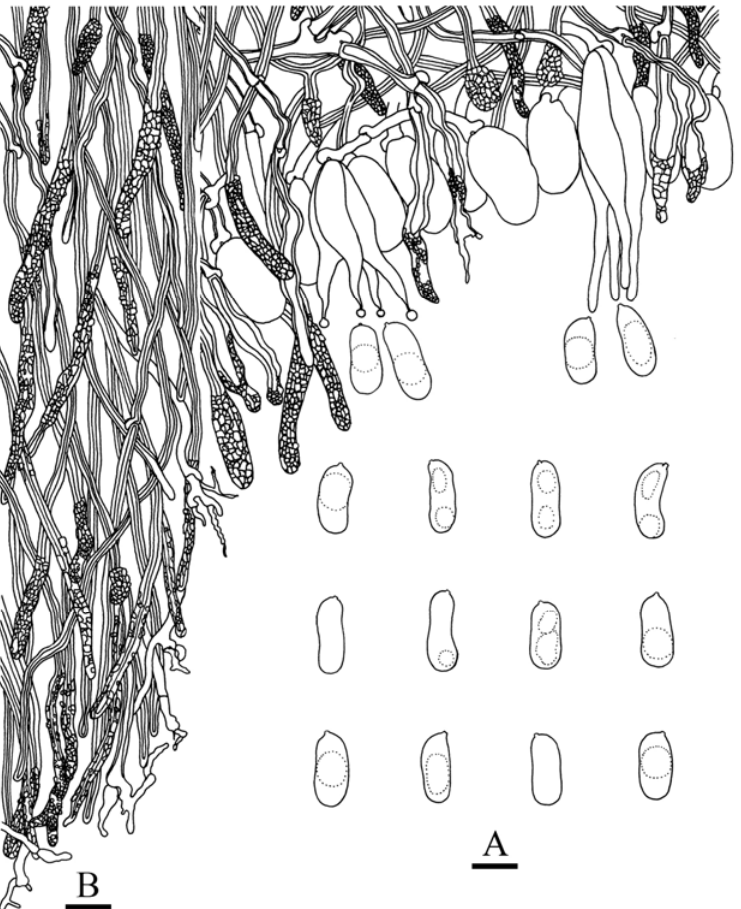
Figure 13. Heteroradulum maolanense (from the holotype, He 4773, BJFC 024290). Scale bars: ( A , B ) = 10 μ m. ( A ). Basidiospores; ( B ). A cross section of the